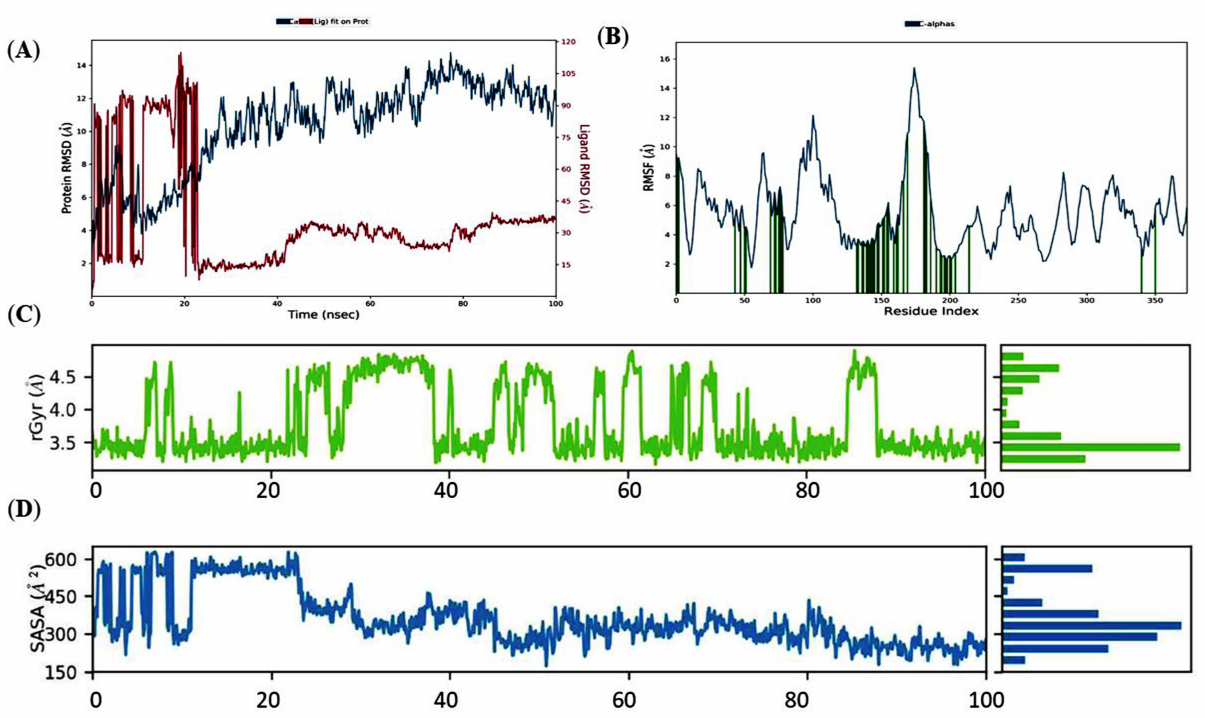
Figure 8. Conformational constancy of ‘Apo’ and ‘Holo’ states of PhcR throughout the simulations. ( A ) Backbone-RMSD of PhcR. ( B ) C α -RMSF profile. ( C ) Rg profile. ( D ) SASA analysis of Apo and Holo states of PhcR protein throughout the